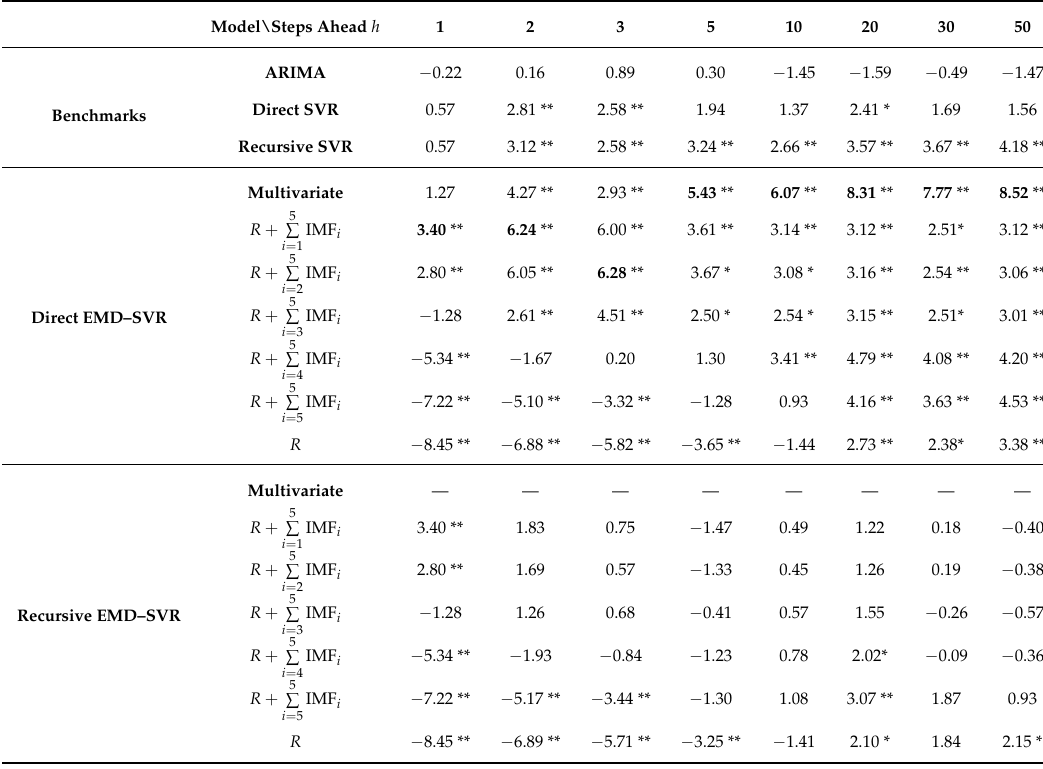
Table 3. Z -statistic for the Wilcoxon signed-rank testing difference between naive model and the other models: autoregressive integrated moving average (ARIMA ( p , d , q ) ), direct and recursive support vector regression (SVR) on the original data, and univariate and multivariate empirical mode decomposition–SVR (EMD–SVR) with input vector m = p + d . Positive values indicate better performances than naive model; negative values indicate worse performance instead. The larger the value, the more significant the overperformance is with respect to naive model. Statistics were computed over all 128 days in the dataset. Best-performing models for each step ahead h are highlighted in boldface. * Statistically significant at the 5% confidence level. ** Statistically significant at the 1% confidence